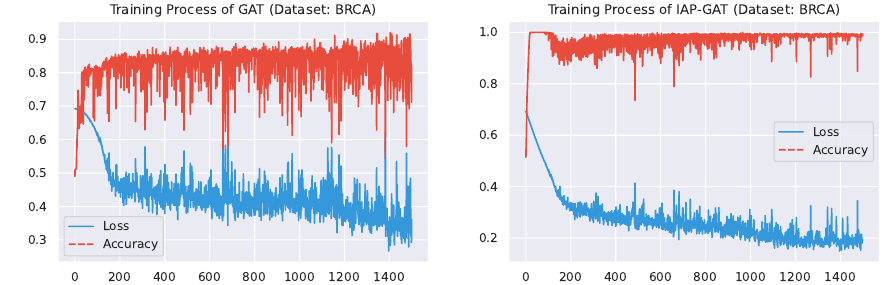
Figure A1. Training process of GAT and IAP-GAT on BRCA dataset.